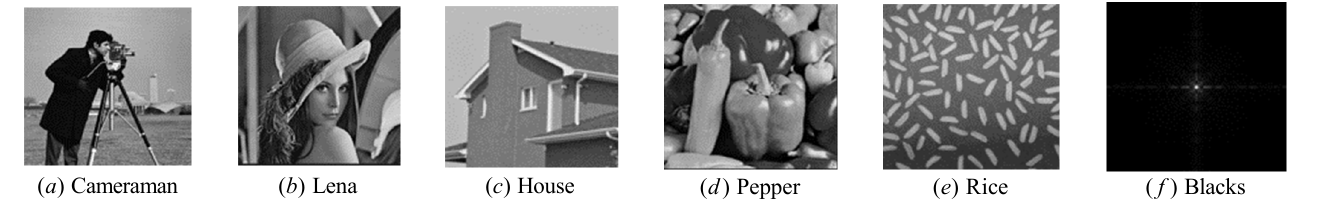
Figure 7. Image used for testing.